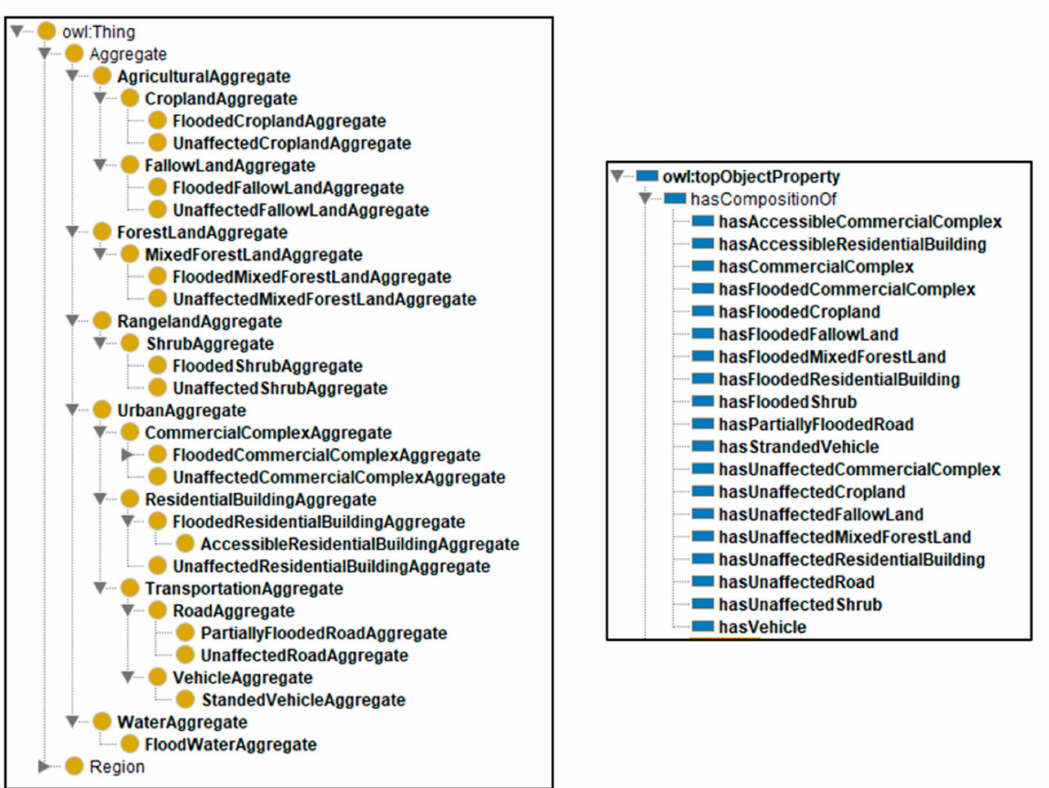
Figure 12. Snapshot of the Aggregate Children Classes and Object Properties in the Flood Scene Ontology that facilitate Spatio-Contextual Triple